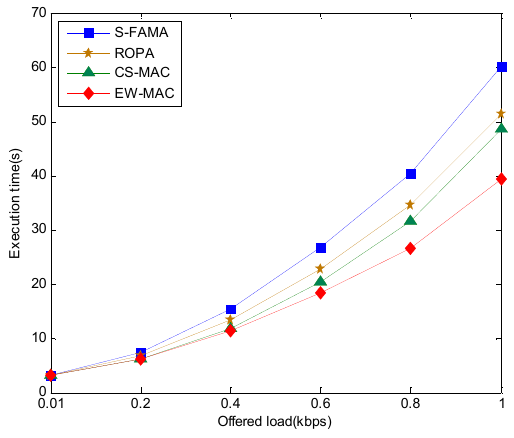
Figure 8. Relationship between execution time and offer load.